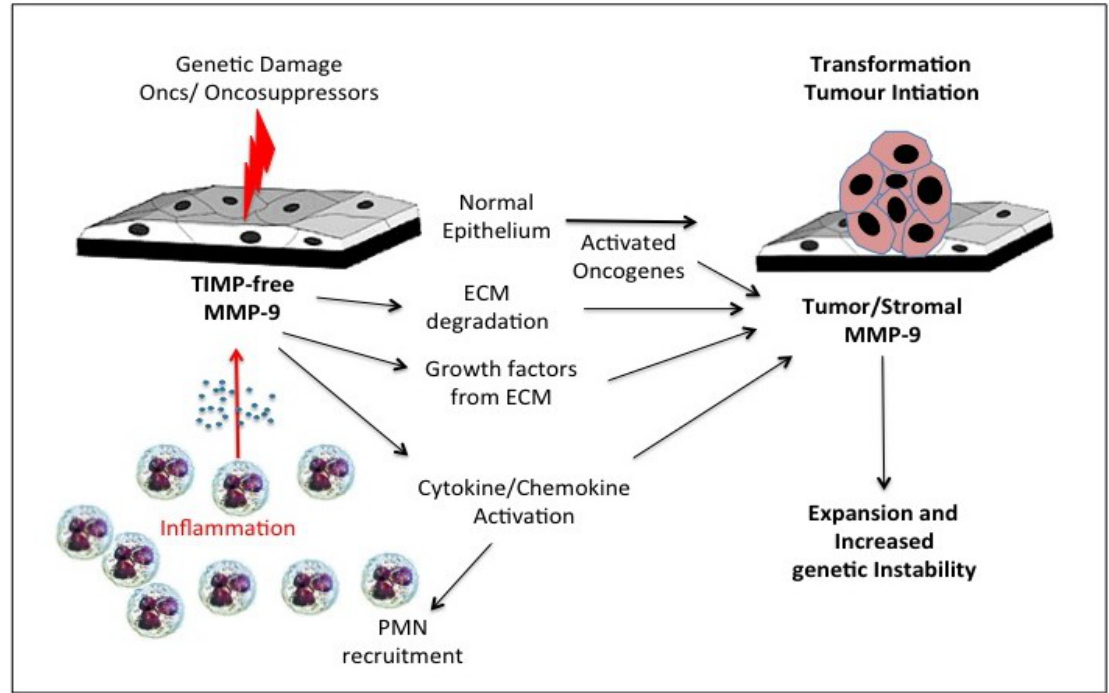
Figure 2. Representation of the role of inflammatory polymorphonuclear leukocyte (PMN)-derived tissue inhibitor of metalloproteinase (TIMP)-free gelatinase B/MMP-9 in tumour initiation and promotion of genetic instability through degradation of extracellular matrices (ECM) release and activation of cytokines, chemokines and growth